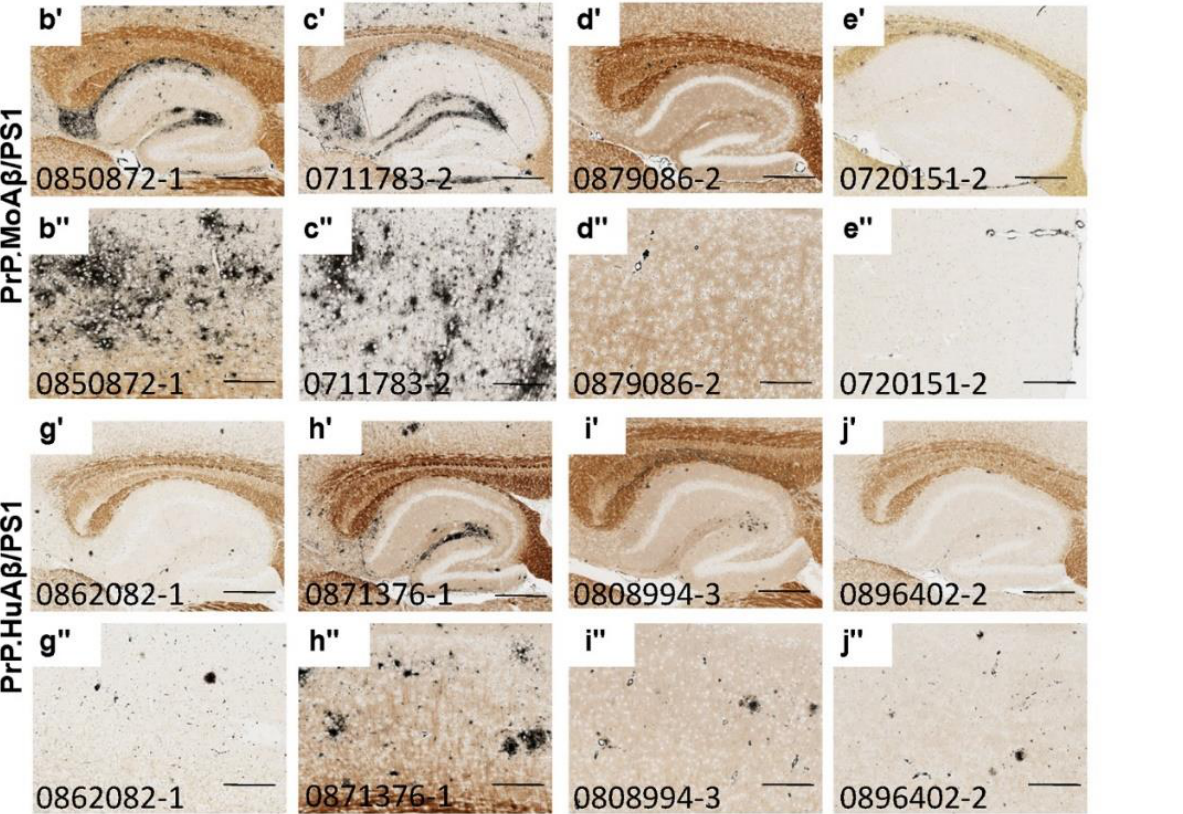
Figure 1. Competition between diffuse and cored strains of A β pathology in APP transgenic hosts. The upper panels show high-power images of A β deposit morphology, revealed by C-S silver staining (see Methods), in the brains of mice that provided seed sources [26] and the recipients of these seeding injections. The lower panels show low-power views of the seeded animals. Details of animal numbers for each injection are summarized in Table 2, with details of individual animals provided in Table